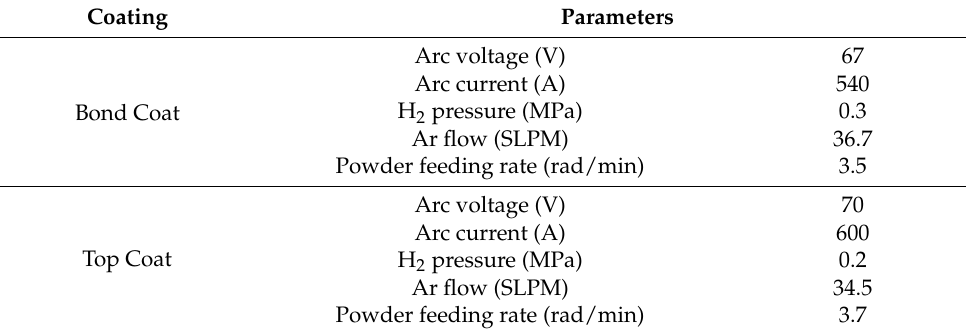
Figure 3. Microstructure of Amdry 997 powder: ( a ) globular; ( b ) Cross-sectional. Table 1. Plasma spraying